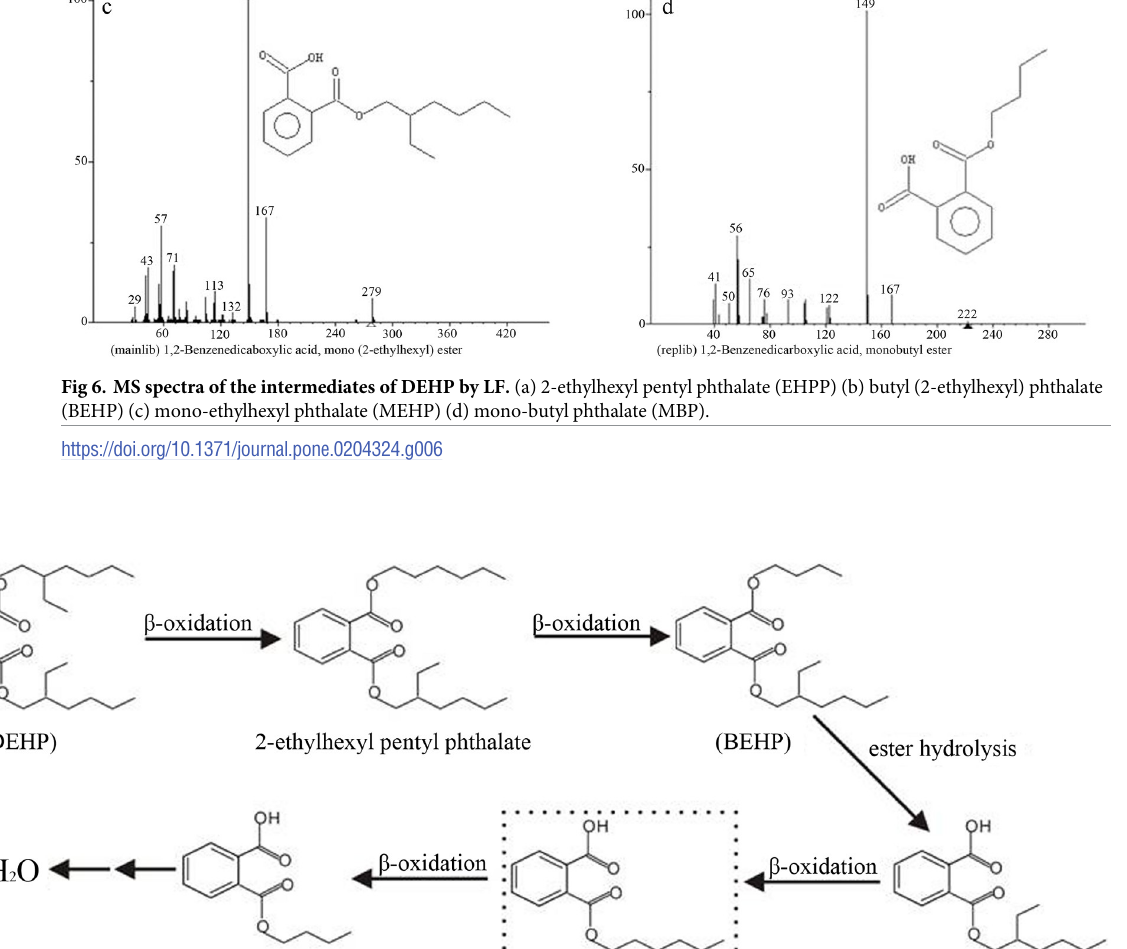
PLOS ONE | https://doi.org/10.1371/journal.pone.0204324 October 15,